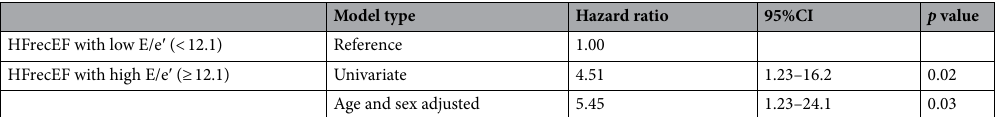
Table 3. Cox regression analysis for the composite of CV death and heart failure readmission after the 1-year follow-up. CI confidence interval, CV cardiovascular, E/e ′ peak velocity of the early wave (E) to early diastole (e ′ ) ratio, HFrecEF heart failure with recovered ejection fraction.